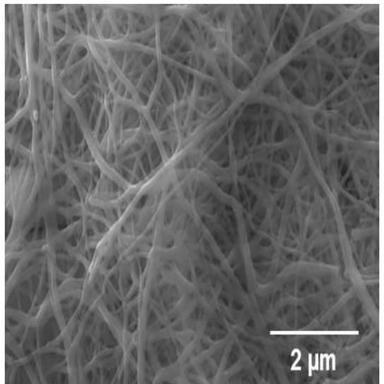
SEM micrograph (SE-mode) of the 10Mg–Zr fibers sintered at 700 °C with a heating rate of 1 K/min.